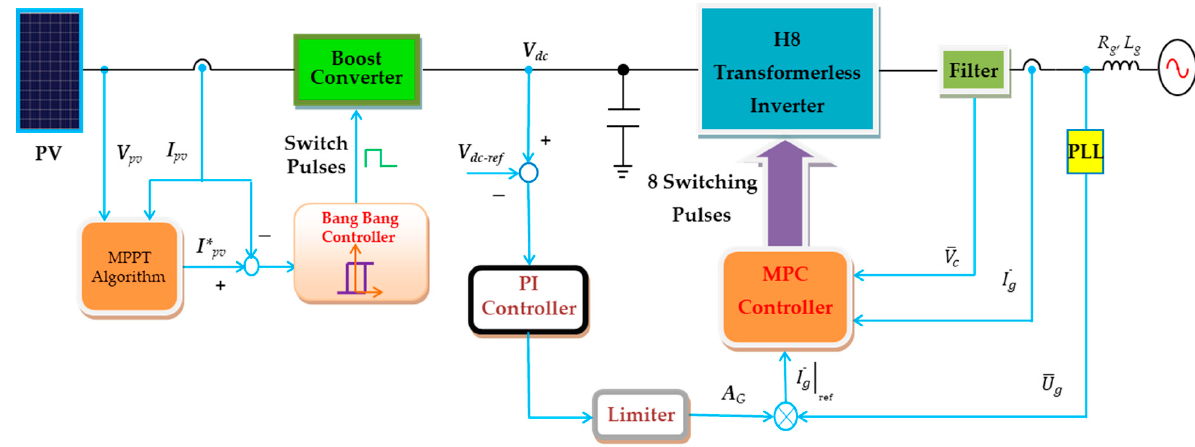
Figure 4. The single line diagram of the proposed system incorporates the system